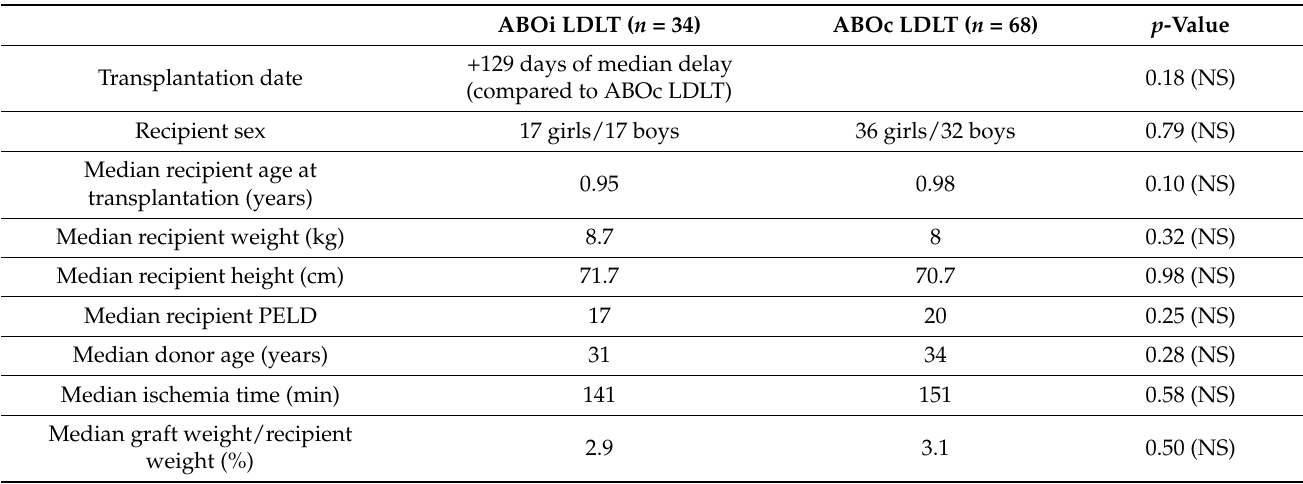
Table 1. Characteristics of 34 ABOi pediatric liver recipients and their control group of 68 ABOc living donor liver transplantations performed at the Cliniques Universitaires St Luc, Brussels, Belgium (September 2003–August 2019). ABOi LDLT ( n = 34) ABOc LDLT ( n =